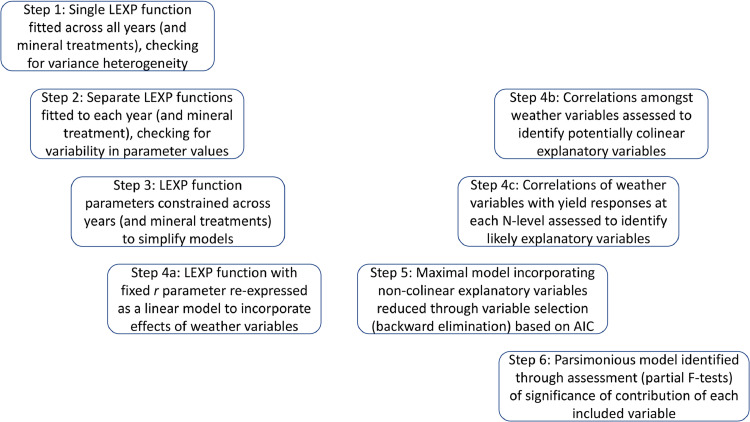
A schematic showing the statistical modelling steps involved in developing parsimonious models to describe the yield response to nitrogen application for both the Broadbalk and Hoosfield Long Term Experiments, including effects of weather variables and variety.